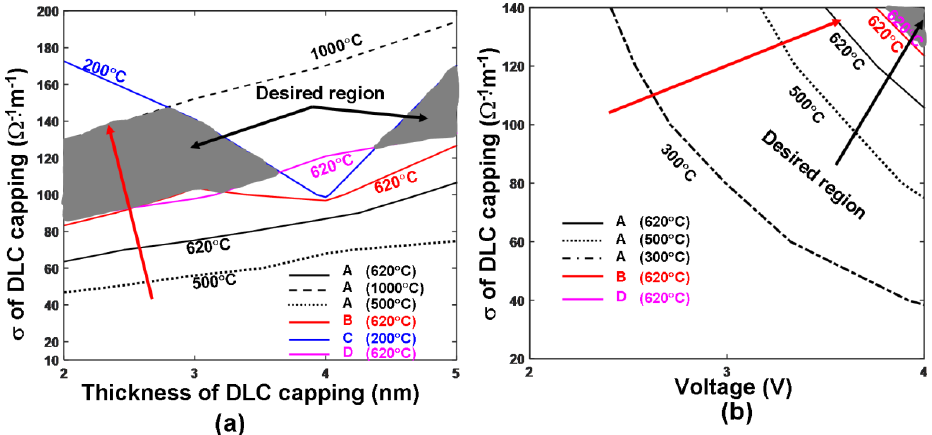
Figure 3. Temperature contours at points A, B, C, D as a function of ( a ) electrical conductivities and thickness of the DLC capping layer; and ( b ) electrical conductivities and tip voltages. For both simulations, the thermal conductivities of the capping and under layer remained at 0.5 W·m −1 ·K −1 and 12 W·m −1 ·K −1 , while other modeling parameters are given in Table 1. Note that for ( b ) maximum temperature contours of 1000 °C at A and 200 °C at C are outside this figure and, therefore, are not visible. The red arrow indicates the direction along which the temperature at A increased.